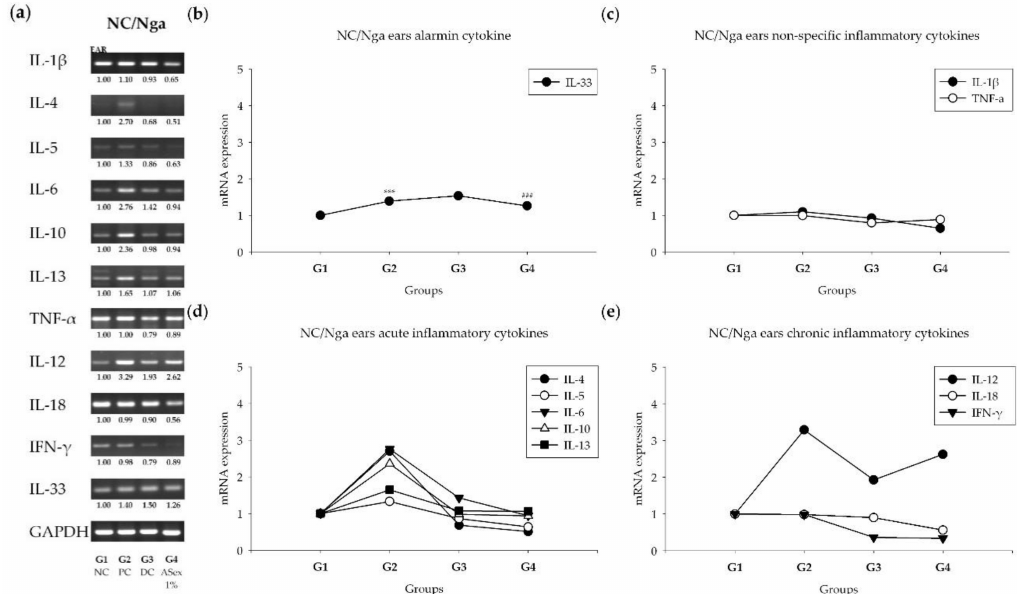
Figure10. ExpressionofinflammatorycytokinesintheearsofNC / Ngamice. ( a ):